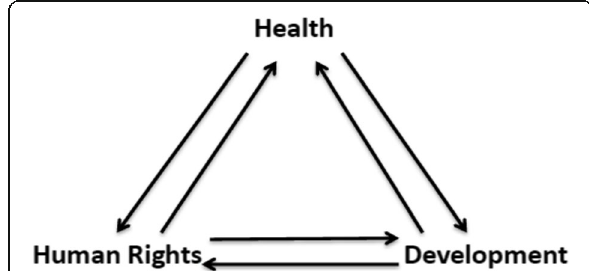
Fig. 1 The Health, Human Rights and Development Triangle (Originally printed in Tarantola et al., 2008 [20] with permission obtained to re-print. This figure has been republished in Tarantola et al., 2013